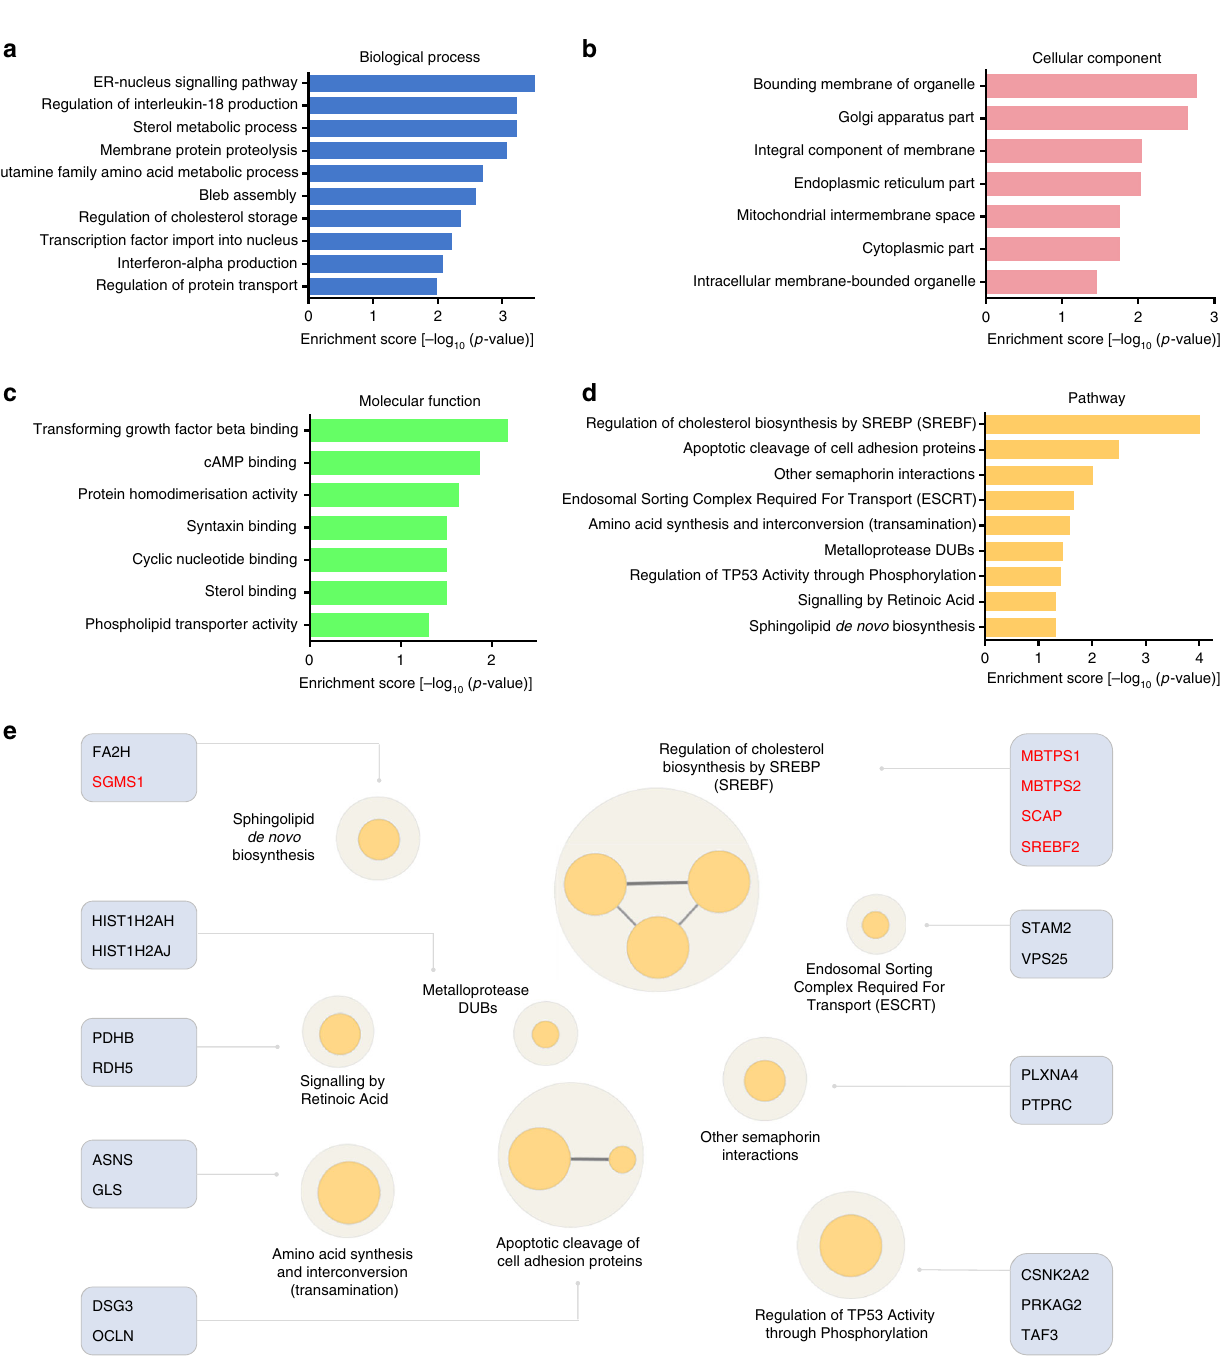
Fig. 4 Enrichment analysis of gene ontology (GO) terms and pathways. a – c GO terms analysis of the signi fi cant screen hits according to a biological process, b cellular component and c molecular function. d Pathway analysis of screen hits based on the REACTOME database. e Enrichment network pathways were generated using the Cytoscape software 57 with ClueGo plug-in 58 . Groups are labelled according to the most signi fi cant pathways of the group and the related gene hits are showed. Genes that were top 10 hits are highlighted in red colour. The node size represents the term enrichment signi fi